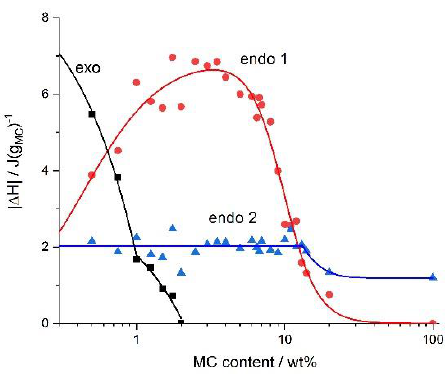
Figure 4. The absolute value of the heat exchanged upon heating during the exothermic, the low-temperature (endo 1) and the high-temperature (endo 2) endothermic effects versus the MC content.